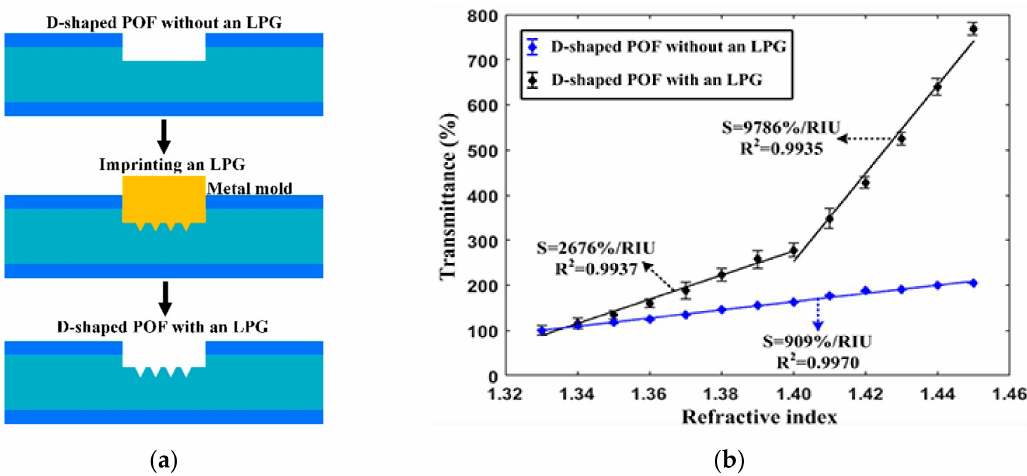
Figure 13. The schemes diagram of fabrication pross of LPG structure on POF ( a ), and ( b ) is the comparison of the experiment data for the D-shape POF probe with and without LPG structure [108].